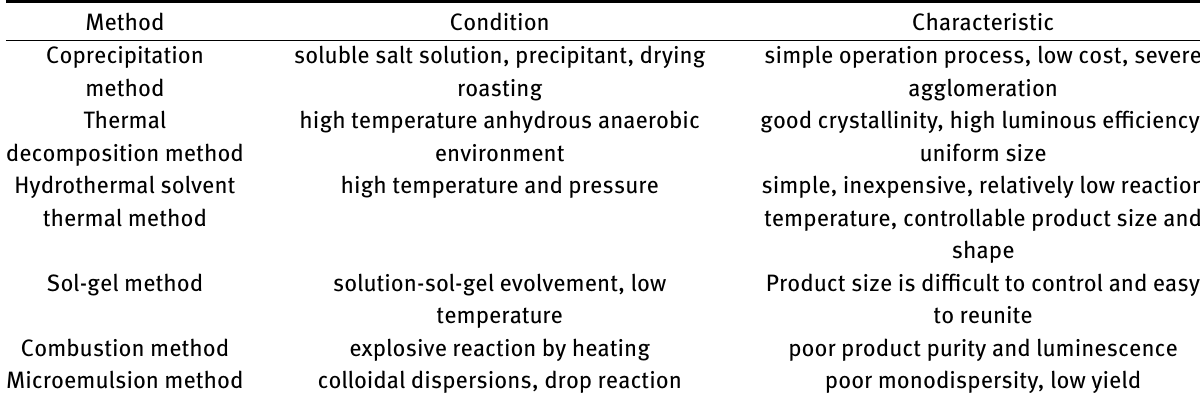
Table 1: Comparison of preparation methods of UCNPs